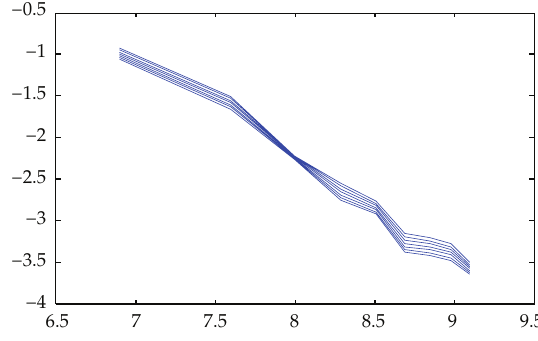
Figure 8: The fitting chart of Chinese medicine group for BI baseline fractal m (cid:8) 4.